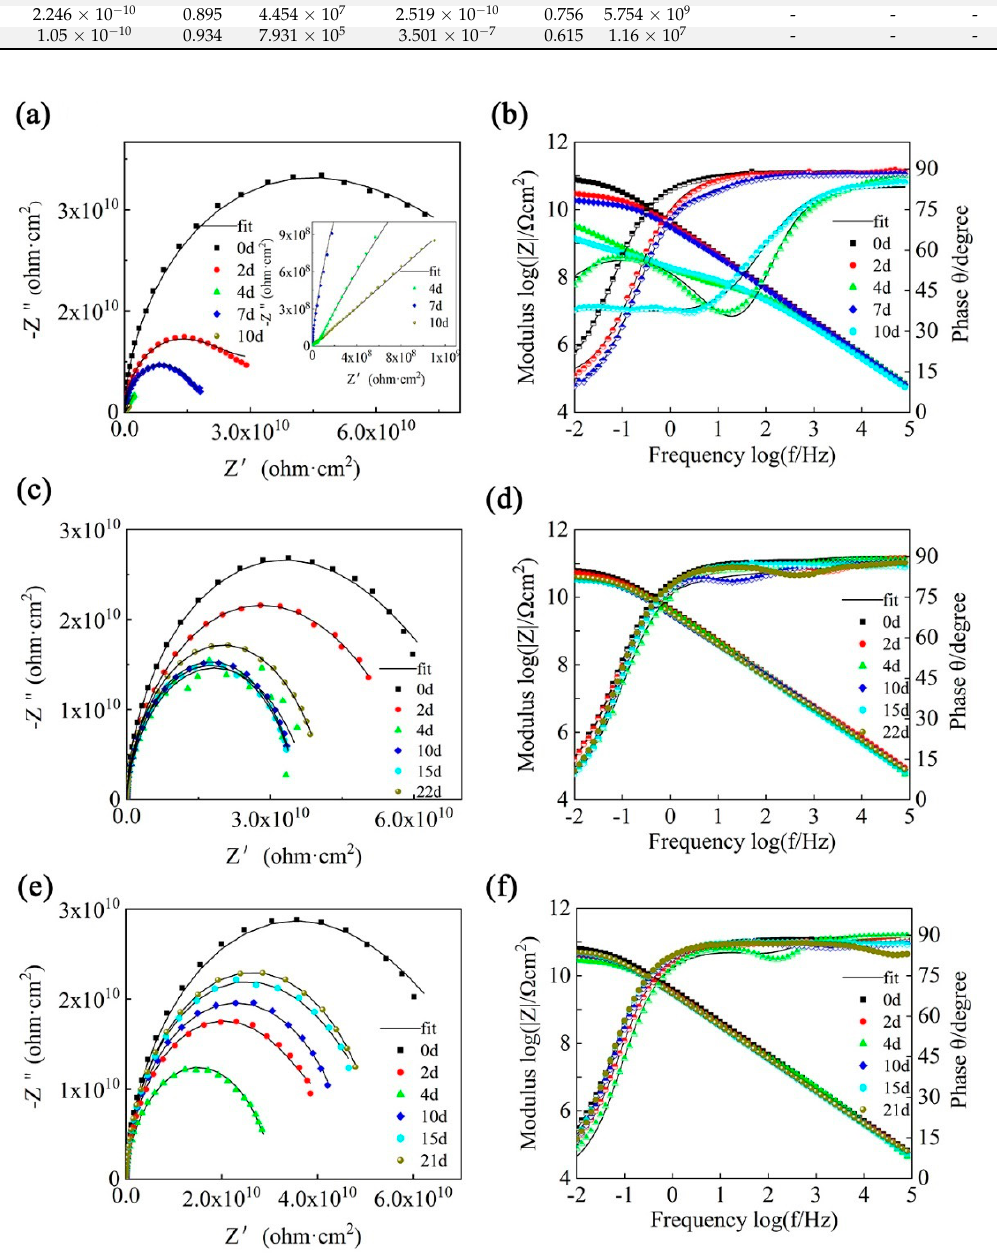
Figure 12. ( a , c , e ) Bode and ( b , d , f ) Nyquist diagrams of the (amb) SiC-G@GO 0.5 coating, ( c , d ) SiC- G@GO 1 coating, and ( e , f ) SiC-G@GO 2 coating at different immersion times in 3.5 wt% NaCl solution. In the EP coatings containing 0.5 wt%, 1 wt%, and 2 wt% SiC-G@GO, the content of 0.5 wt% SiC-G@GO is too small to be effective in terms of the role played by SiC-G@GO.